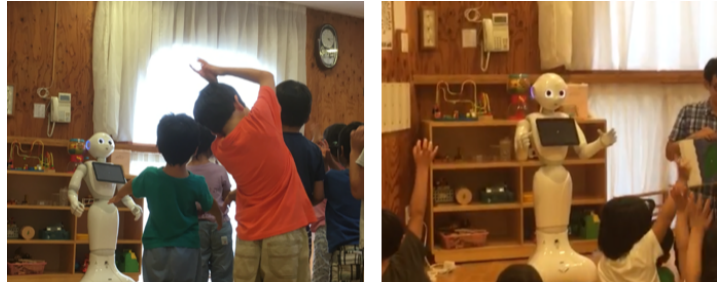
Figure 6. Example of a Children Robot Interaction ” in the wild ” application developed by end users using RIZE and Pepper